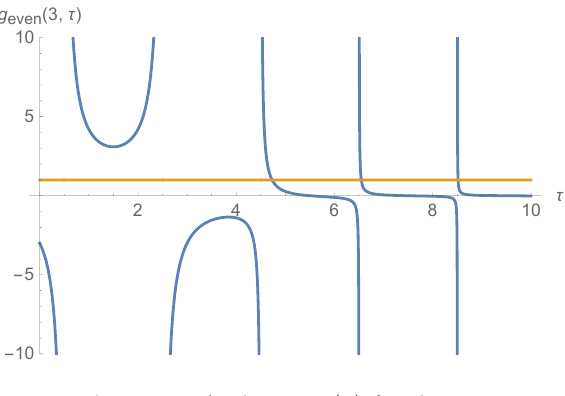
Figure 9. A plot g even ( (cid:28) ) for d =